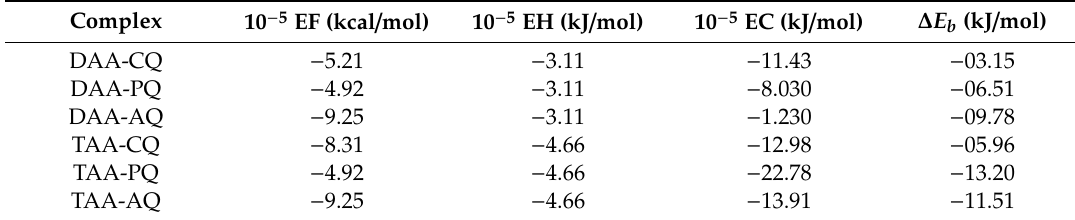
Table 2. Geometry energy values from drugs (EF), hydrogel model (EH), complex (EC) and binding energy ( ∆ E ) corrected with basis-set superposition error (BSSE) at the wb97xd / 6-31 ++ G(d,p) level of